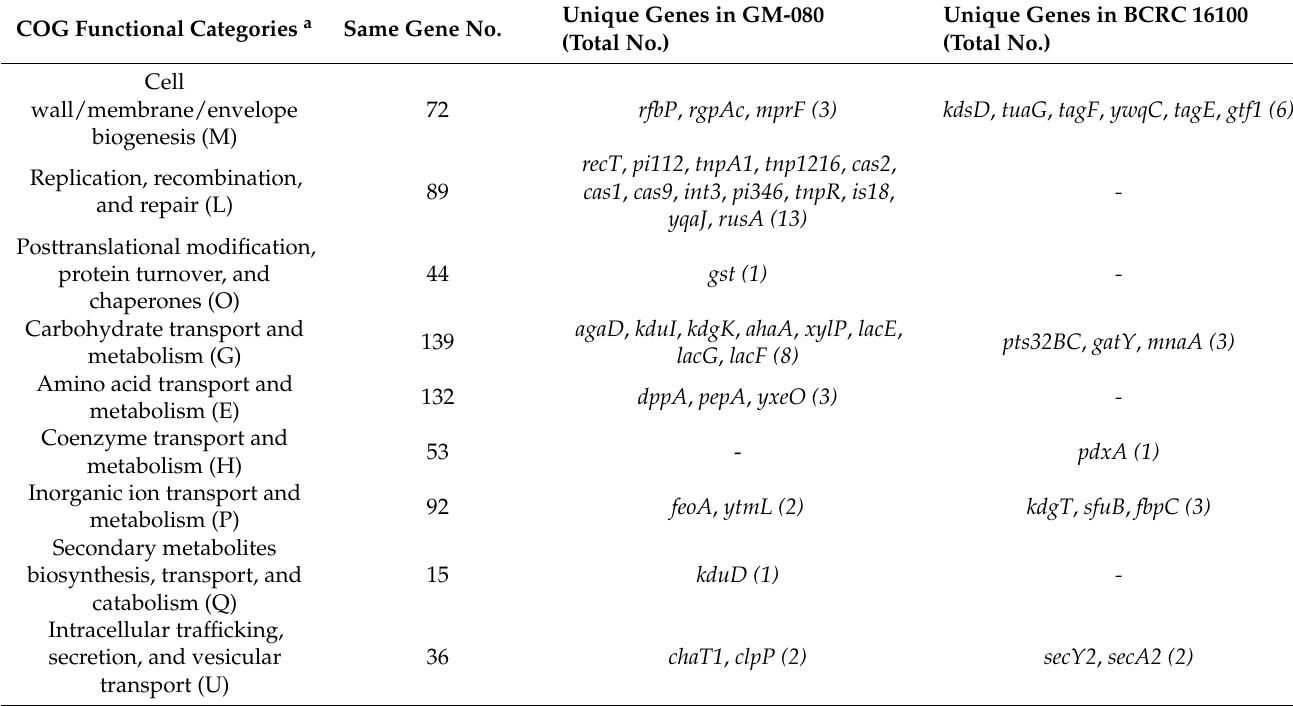
Table 1. COG functional categories of GM-080 and BCRC